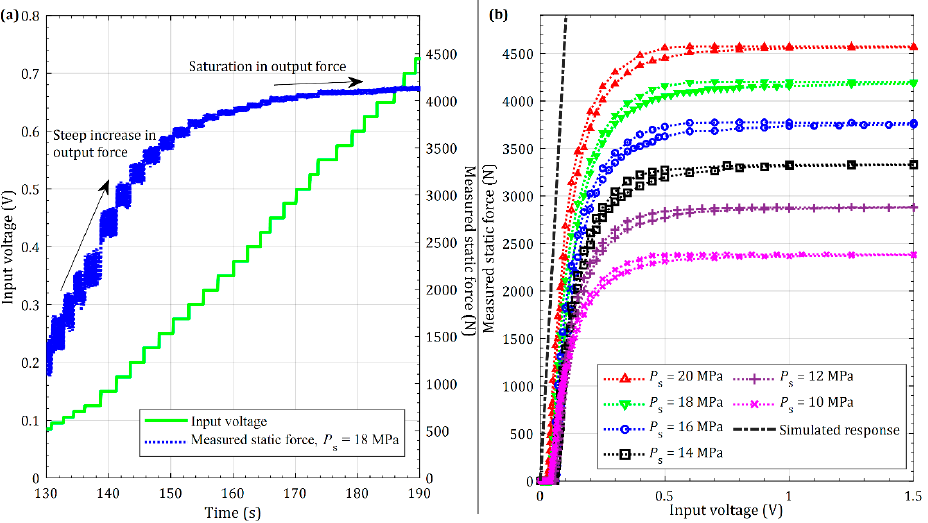
Figure 4. ( a ) Variations in static force with input voltage at a supply pressure of 18 MPa, and ( b ) measured force characteristics for changing levels of voltages and supply pressures compared with linear model-predicted forces changing with